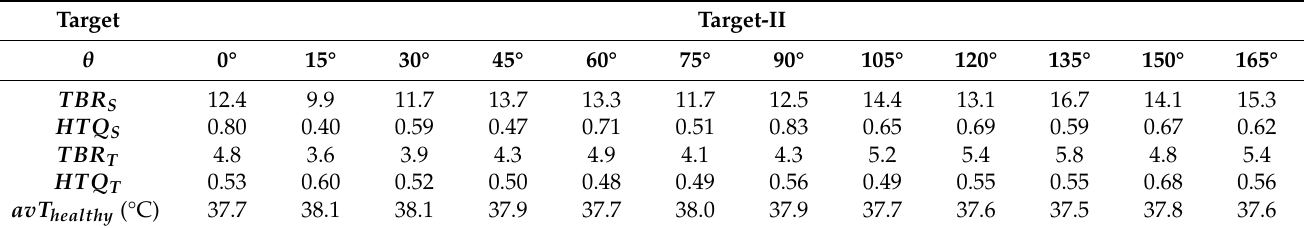
Table 3. Focusing results of the linear MH applicator at target-II with changing the antenna number and rotation